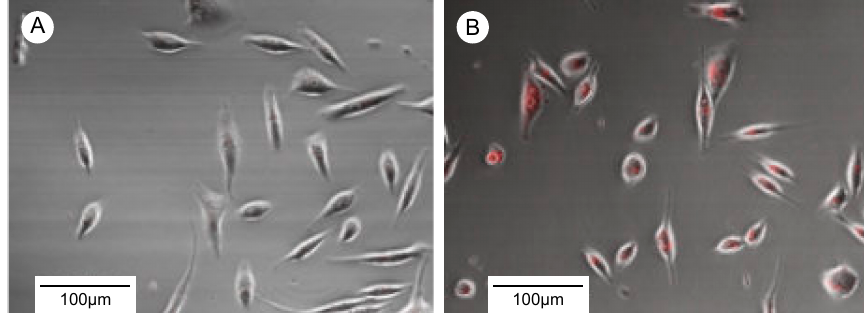
Figure 7. Fluorescently labeled aptamer IDA is internalized by integrin presenting PC-3 cells. Cells were incubated with fluorescently labelled non-specific DNA ( A ) and aptamer IDA ( B ) as described [41]. Scanning microscopic analysis after treating both samples with DNase showed clearly labelled molecules inside cells.